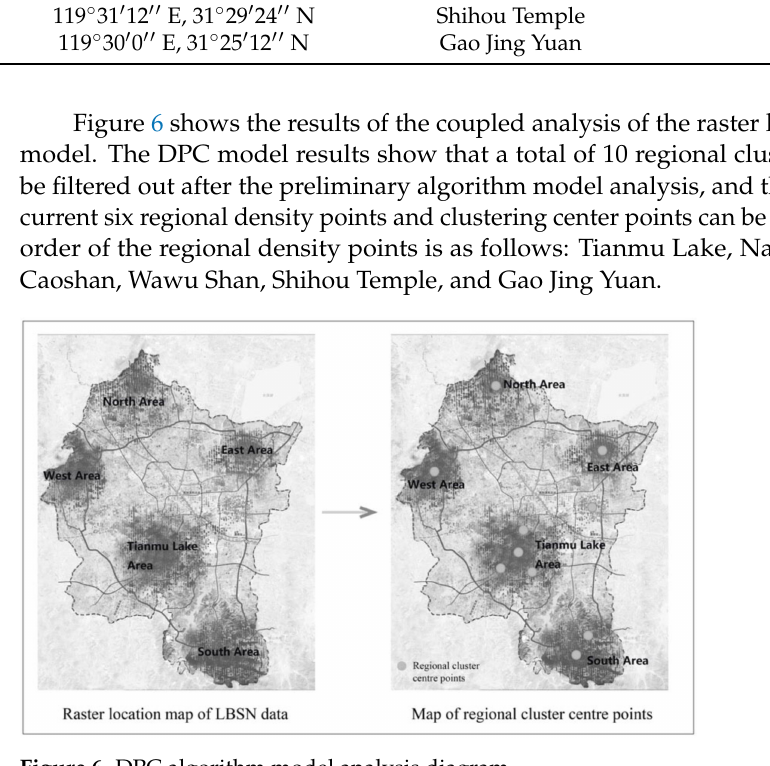
Figure 6. DPC algorithm model analysis